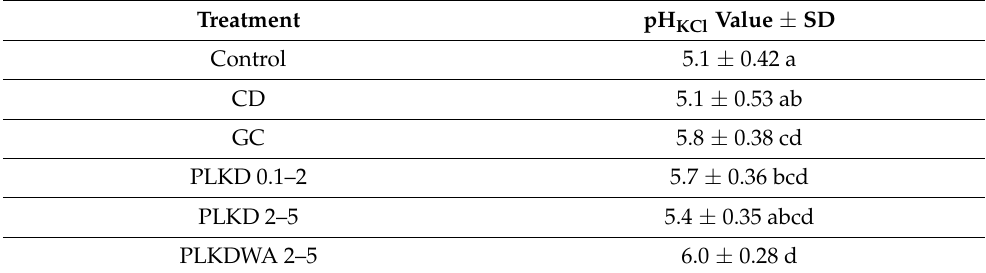
Table 3. pH KCl values after 27 months of